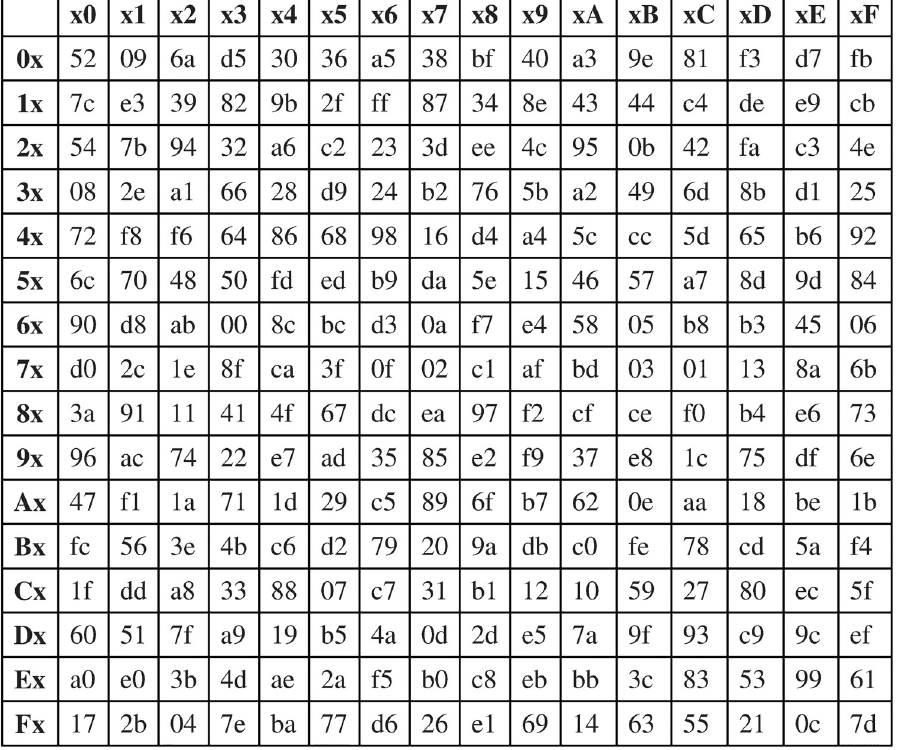
Fig 8. The S-BOX